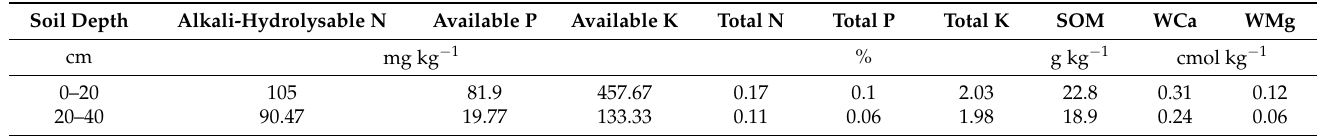
Table 1. Soil property of the peach orchard at soil depth of 0–20 cm and 20–40 cm before treatment in